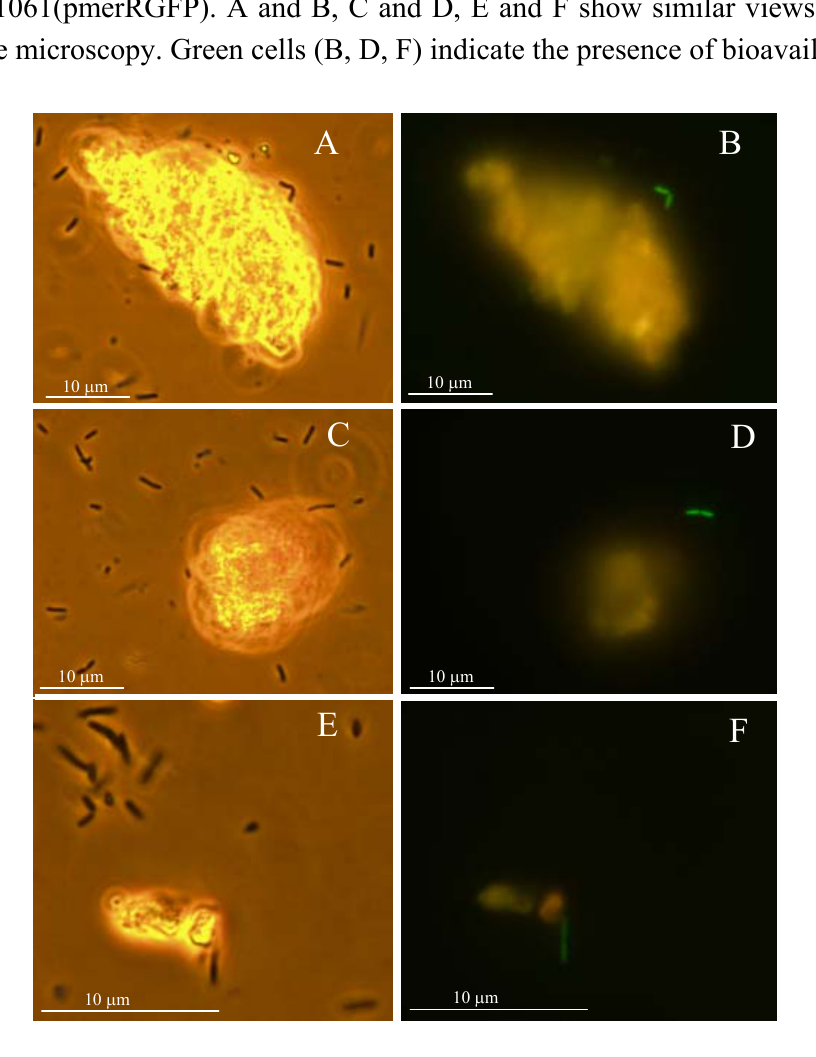
Figure 2 . Induction of GFP in Hg sensor Escherichia coli MC1061(pmerRGFP) in